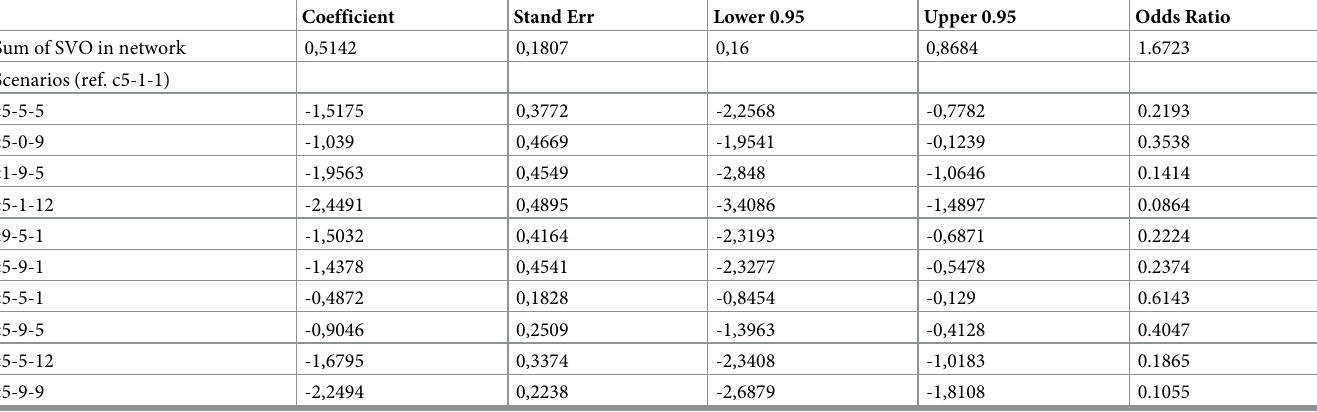
Table 2. Logistic regression of aggregated SVO and scenarios on NSR-N on the network level.